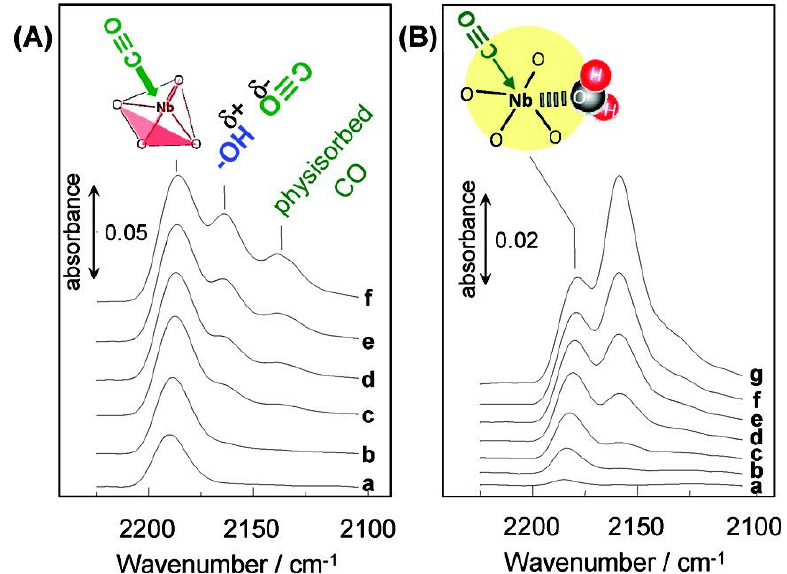
Figure 15. Differential FT-IR spectra for ( A ) dehydrated and ( B ) hydrated Nb 2 O 5 · n H 2 O at 90 K. ( A ) Prior to CO adsorption, the sample was heated at 423 K for 1 h under vacuum. Gas phase CO pressure: ( a ) 7.1 × 10 −3 , ( b ) 1.2 × 10 −2 , ( c ) 2.2 × 10 −2 , ( d ) 4.0 × 10 −2 , ( e ) 6.6 × 10 −2 and ( f ) 1.4 × 10 −1 kPa.